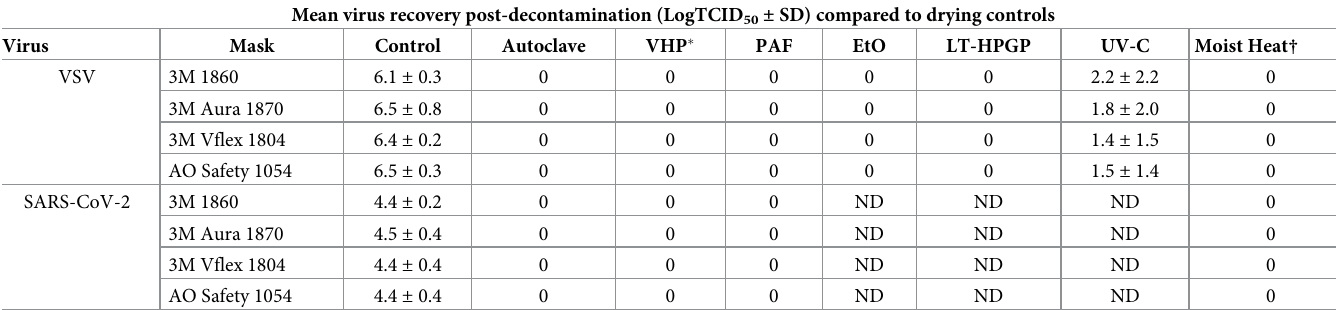
Table 1. Sterilization efficacy of decontamination